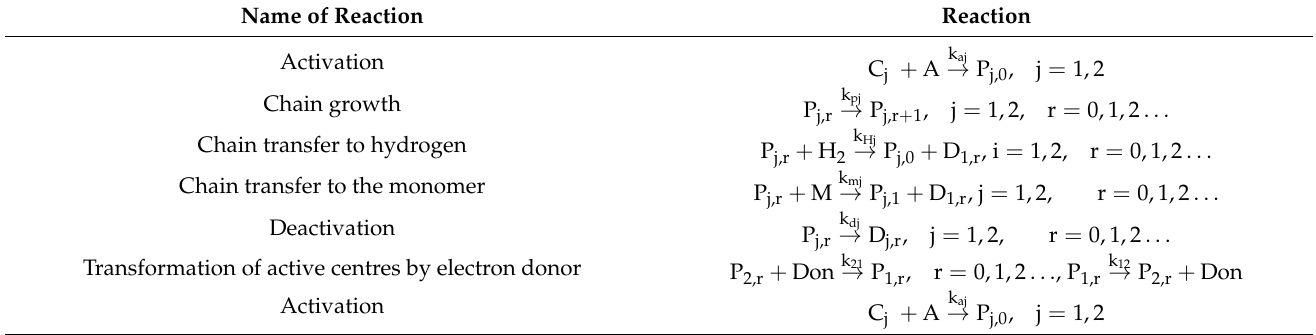
Table 1. The mechanism of the polymerization reaction of polypropylene on a titanium–magnesium catalyst.